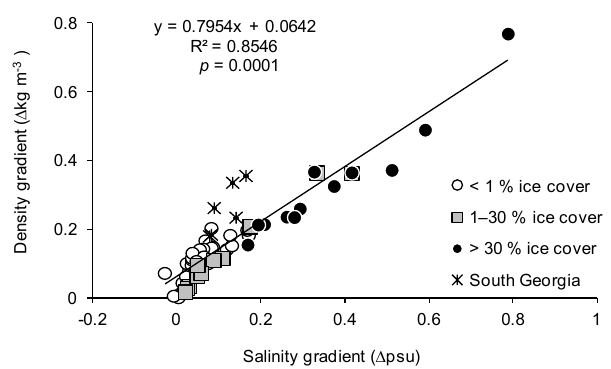
Figure 6. The role of seasonal ice melt for water column stratifica- tion. During spring–summer 2003, the maximum density gradient per 10m water column was a linear function of the co-occurring salinity gradient, with strongest density gradients at stations that had been ice covered by >30% 1 month before sampling. The remaining variability in the density gradient is explained by tem- perature (GLM: density gradient = 0.00254 + 0.7255 salinity gra- dient + 0.07828 temperature gradient; R 2 =